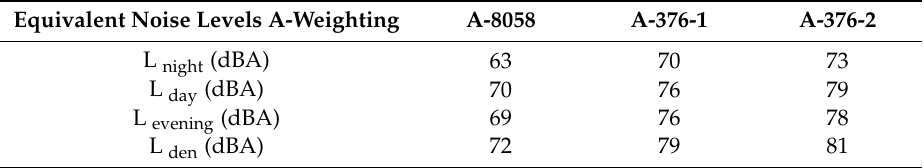
Table 1. Equivalent sound pressure level values.